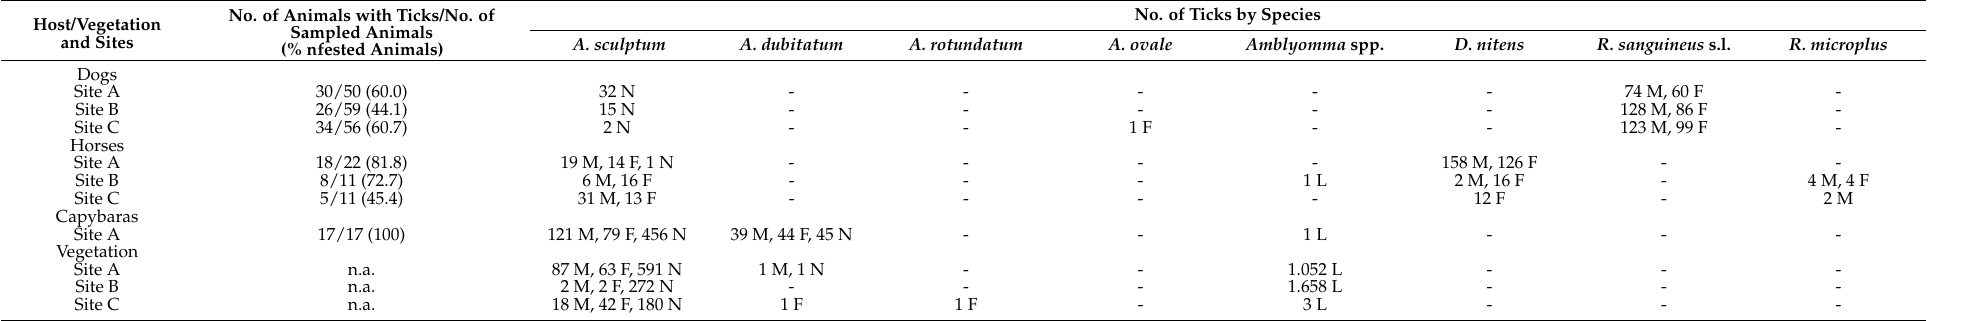
Table 2. Number and species of ticks collected from dogs, horses, capybaras and vegetation, in the city of Goi â nia, state of Goi á s, midwestern Brazil, between March 2020 and April